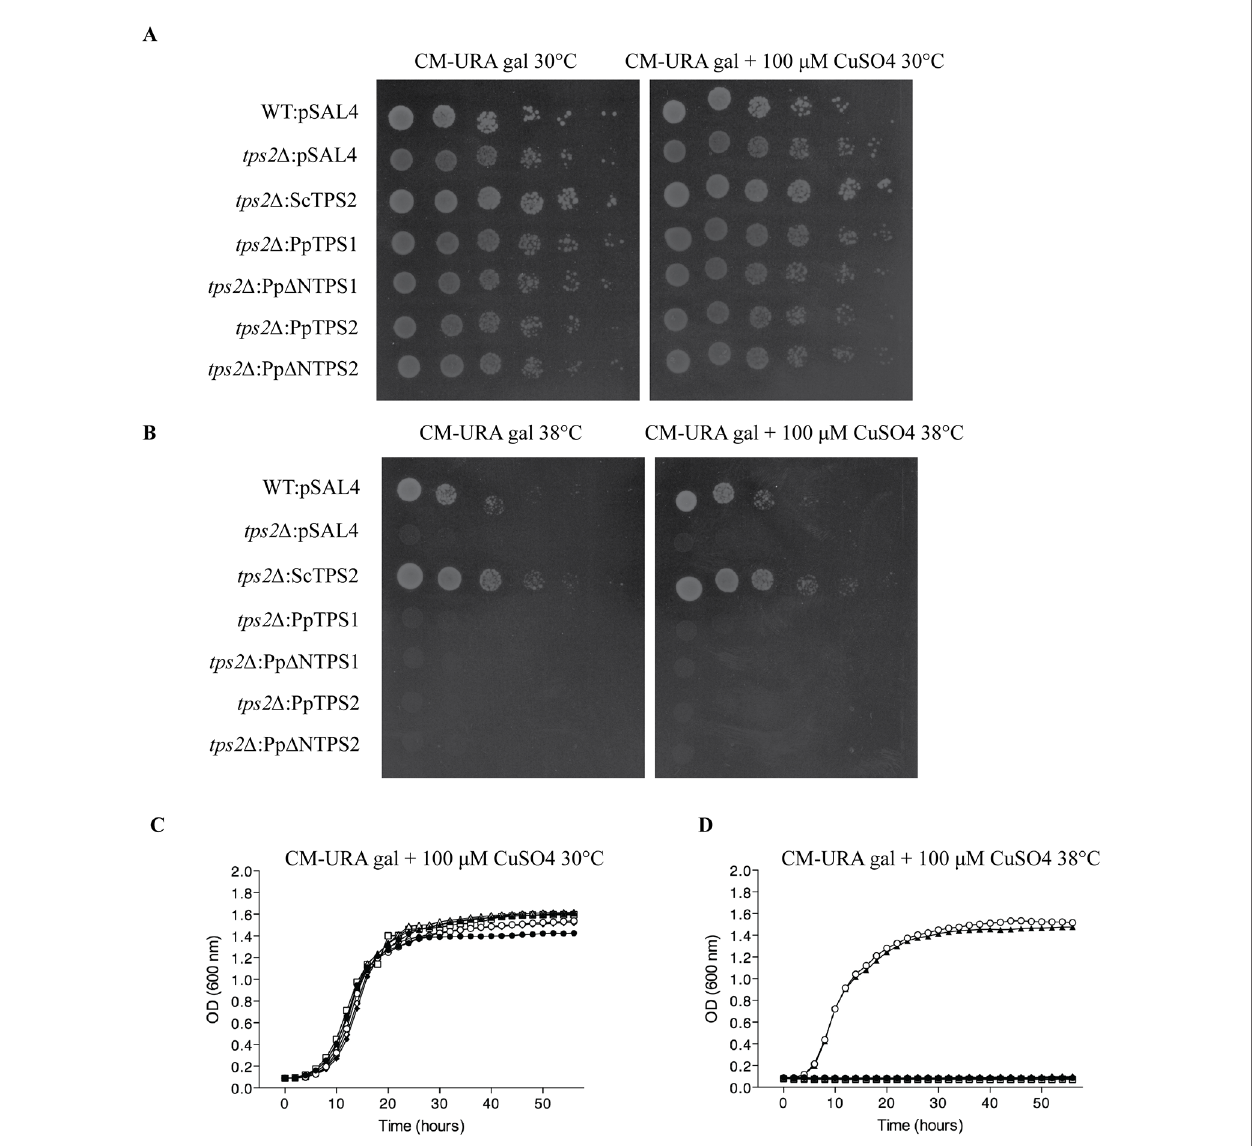
FIGURE 5 | Complementation studies of PpTPS1 and PpTPS2 in the yeast tps2 Δ mutant at 30°C or 38°C. Complementation assay was performed on plates supplemented with 2% galactose with or without 100 m M copper sulfate at 30°C (A) and 38°C (B) . Bioscreen analysis was done at 30°C (C) and 38°C (D) . Wild- type (WT) strain transformed with pSAL4 ( ▲ ), the deletion strain transformed with ScTps2 ( ○ ), pSAL4 ( ● ), PpTPS1 ( △ ), PpTPS2 ( ◆ ), Pp D NTPS1 ( □ ), or Pp D NTPS2 ( ◇